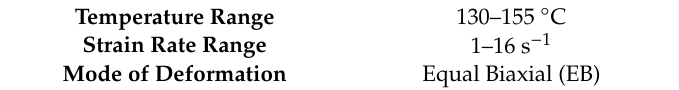
Table 1. Specifications of planar biaxial stretching conditions [13].